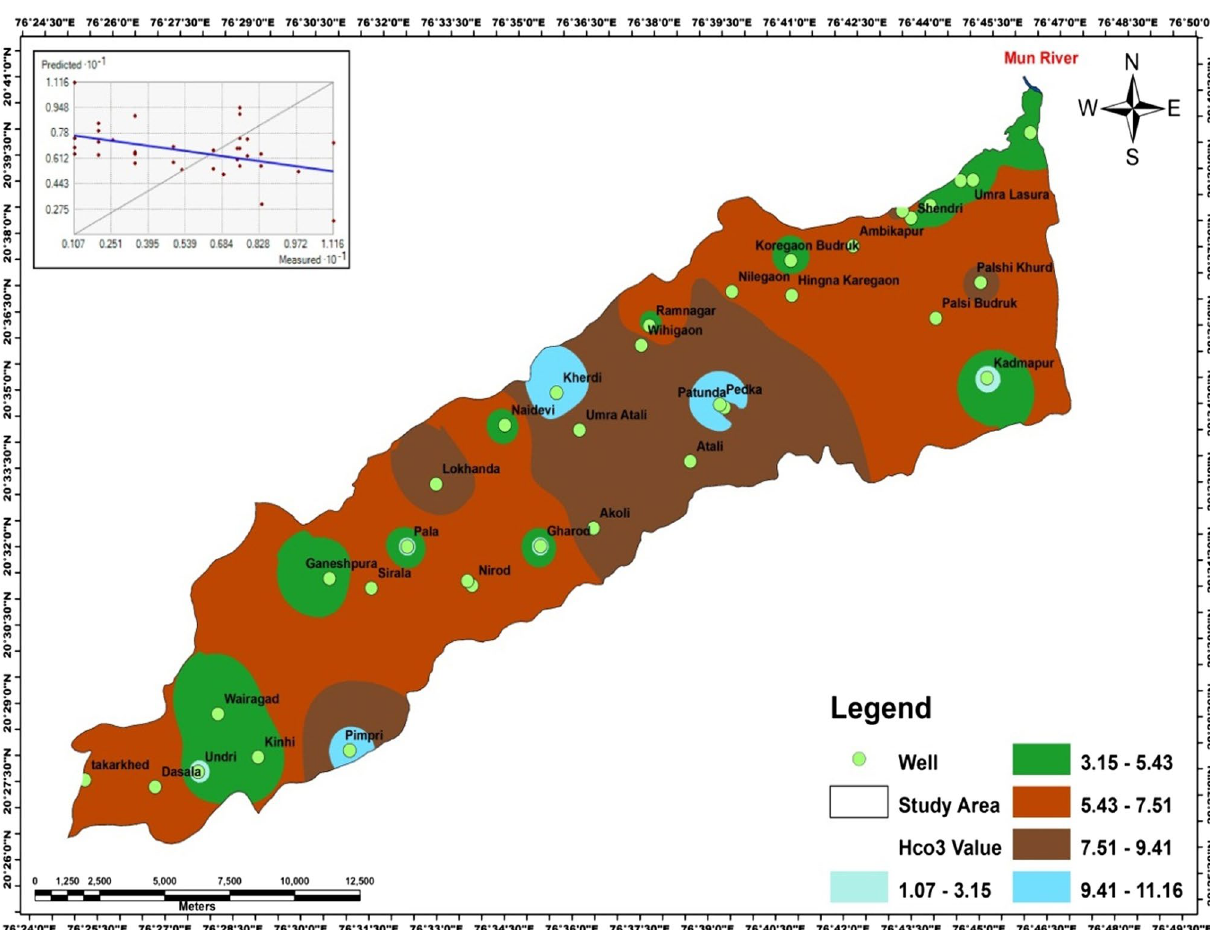
Fig. 12 Spatial distribution map of HCO